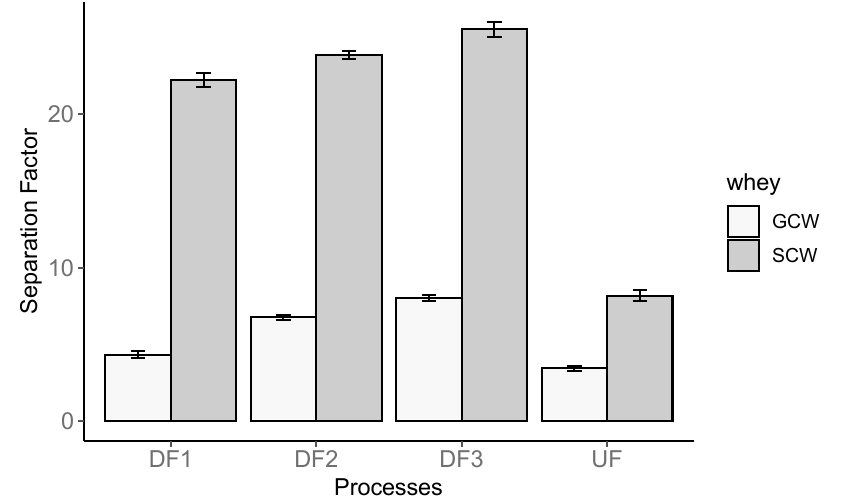
Figure 3. Variation of separation factor along UF/DF process of goat cheese whey (GCW) and second cheese whey (SCW) from sheep, obtained at ∆ P = 2.0 × 10 5 Pa, v = 0.92 m s − 1 and T = 25 °C